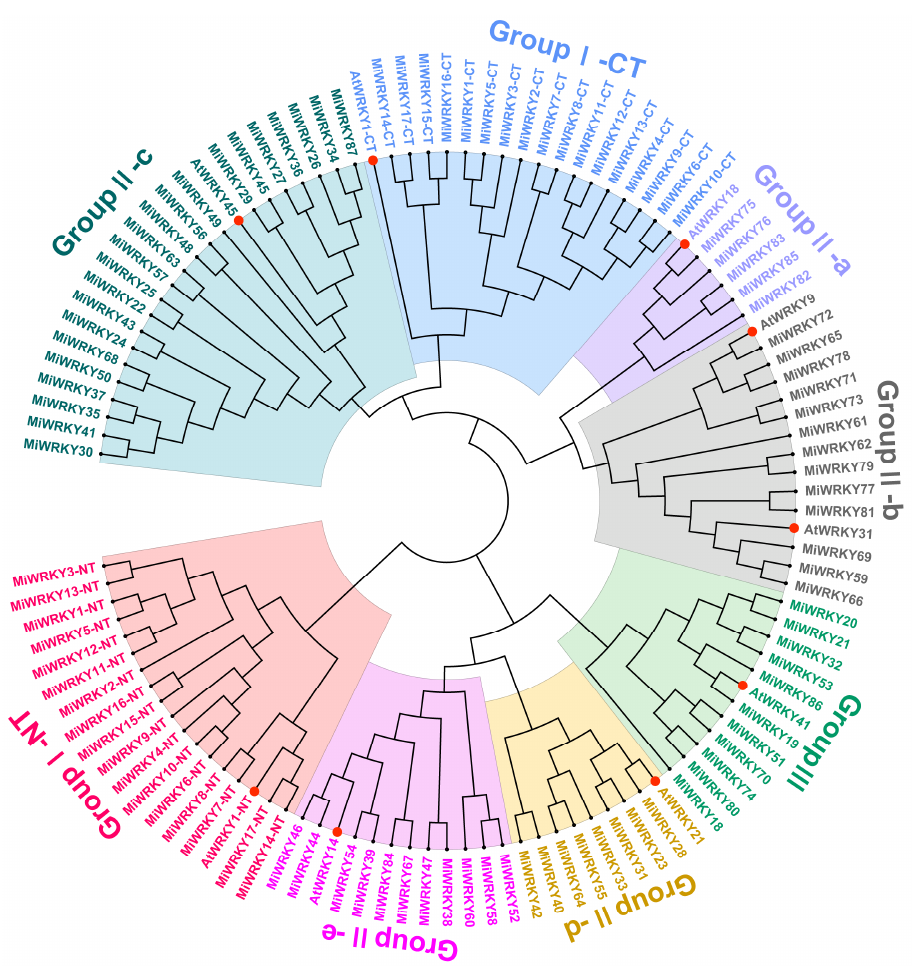
Figure 1. Phylogenetic tree of identified MiWRKY proteins. Select AtWRKY proteins served as representatives for the different groups. Group I to Group III WRKY proteins are shown in different colors. The mango and Arabidopsis WRKY domains are represented by black solid circles and red circles, respectively. WRKYs named with the suffix -NT or -CT represent either the N-terminal WRKY domain or the C-terminal WRKY domain of MiWRKY proteins with two WRKY domains.